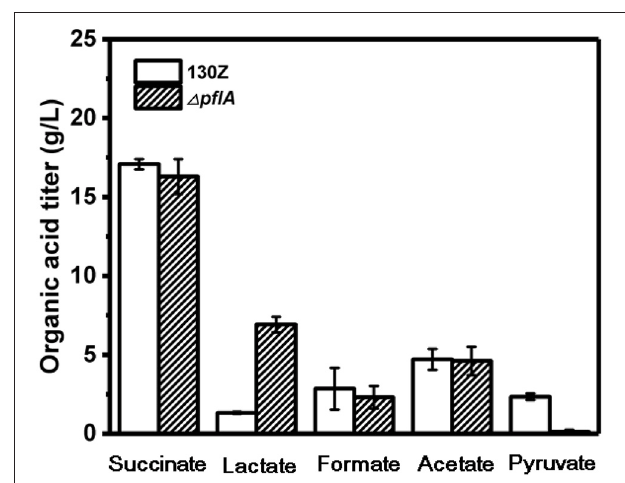
FIGURE 2 | Comparison of different organic acids production between wild-type A. succinogenes 130Z and 1 pflA strains.